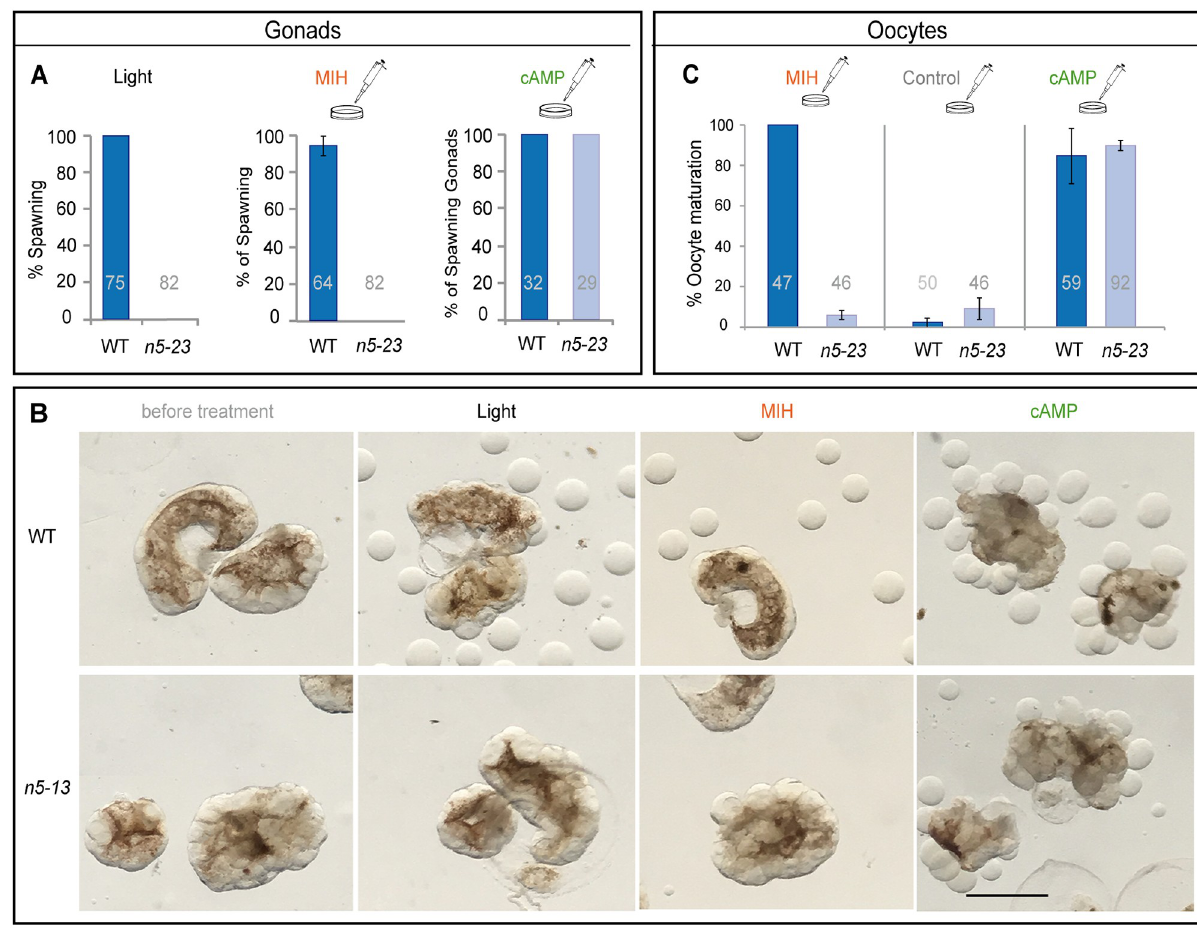
Fig 4. Oocyte maturation failure in MIHR mutant medusae. Oocyte maturation assays performed using isolated gonads (A, B) or isolated oocytes (C) from MIHR mutant jellyfish compared to WT. In A and C, bar heights represent mean percentages of 3 independent experiments and error bars show standard deviations. Total gonad or oocyte numbers for each treatment are indicated in gray. (A) Spawning response of isolated gonads from WT and n5-23 female medusae. Three treatments were compared as indicated above each panel: Light: light stimulation after incubation in the dark; MIH: treatment of light-maintained gonads with 100 nM WPRPamide; cAMP: treatment of light-maintained gonads with 4 mM Br-cAMP. No oocyte maturation or spawning was observed in MIHR KO gonads upon light stimulation or MIH treatment, while Br-cAMP treatment provoked oocyte maturation and spawning. The Fisher exact test showed significant differences (F = 0) between wild-type and mutant responses to light and MIH, but not for the cAMP treatment (F = 1). Full datasets from three independent experiments are available in S3 Data. (B) Light microscope images illustrating gonads from an equivalent experiment performed with n5-13 female MIHR mutant medusae 120 minutes after the indicated treatments. Scale bar: 500 μ m. (C) Response of fully grown oocytes isolated from WT and n5-23 MIHR mutant gonads to MIH and Br-cAMP treatments as in A. Both treatments triggered maturation of WT oocytes, visible after 20 to 30 minutes as germinal vesicle breakdown (GVBD), but only Br-cAMP induced maturation of MIHR KO oocytes. Control experiments using the Br-cAMP solvent (distilled water) showed a low level of spontaneous maturation in both cases. The Fisher exact test did not show significant differences between WT and mutant oocytes in the control (F = 0.101) or cAMP-treated (F = 0.216) groups, but did so in the MIH assays (F = 0). Full datasets from 3 independent experiments are available in S3 Data. Br-cAMP, bromoadenosine 3 0 ,5 0 -cyclic monophosphate; cAMP, cyclic adenosine monophosphate; KO, knockout; MIH, maturation-inducing hormone; MIHR , MIH receptor; WT, wild-type.